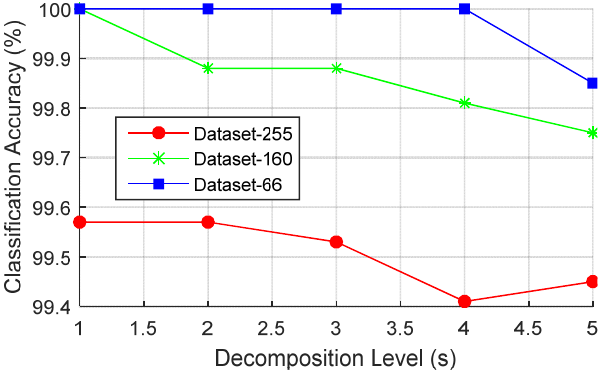
Figure 8. Classification Accuracy versus Decomposition Level ( s ).